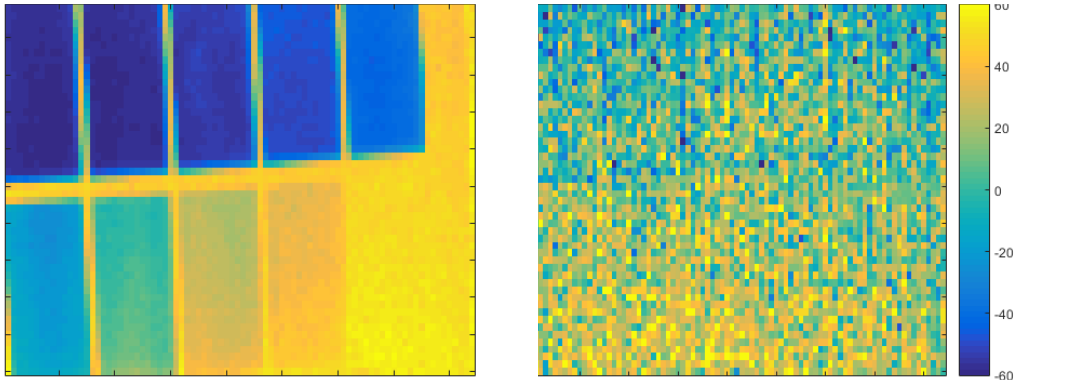
Figure 8. Intensity checker board (left) and depth image from the same view (right). The depth value is given in mm, measured at a distance of 1200